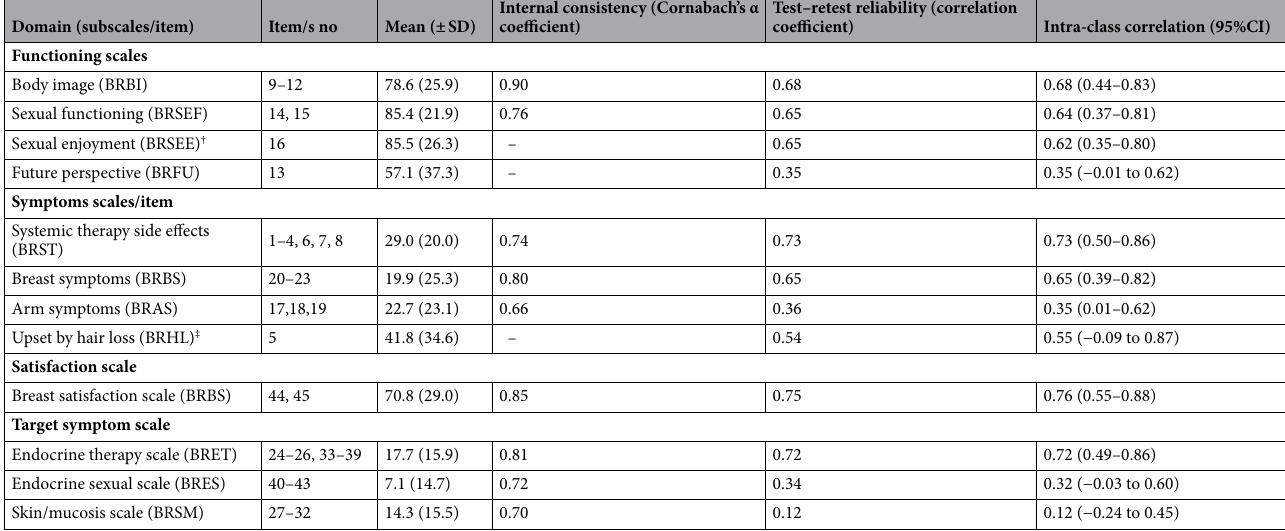
Table 2. Reliability of EORTC QLQ BR45 Amharic version among breast cancer patients in Ethiopia, 2021. † BRSEE, sexual enjoyment, is not applicable if item 15 is “not at all”. ‡ BRHL, upset by hair loss, is not applicable if item 4 is “not at all”. CI confidence